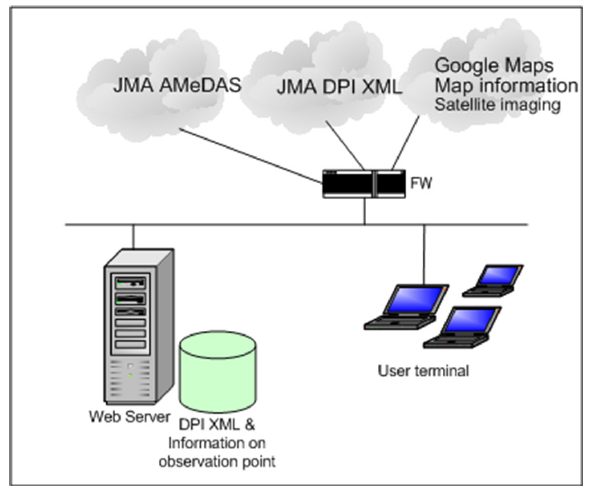
Figure 10. Flow of processing of DPI XML data